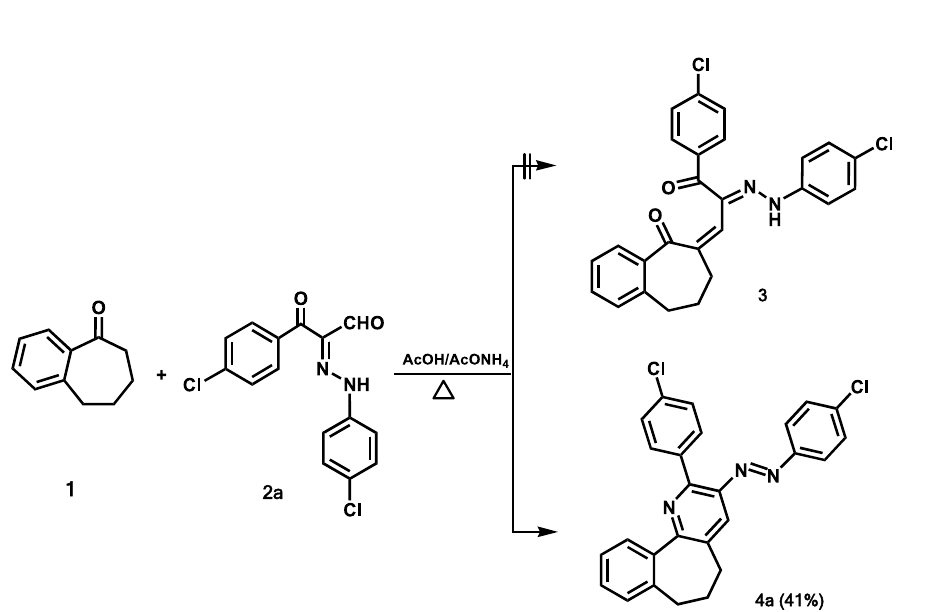
Scheme 1. Reactions of benzosuberone 1 and arylhydrazonal 2a